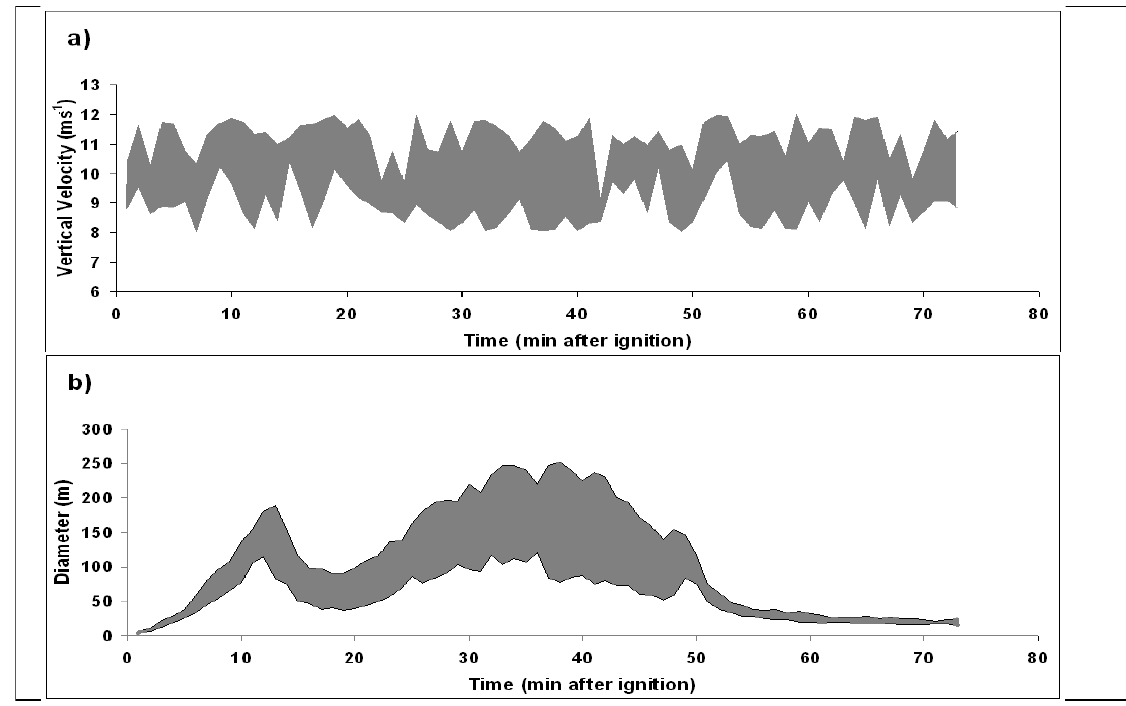
Figure 10. 1-min time-series from Rabbit Rules for ( a ) Initial vertical velocity and ( b ) Initial effective plume diameter for the range of updraft cores calculated for the 6 February 2011